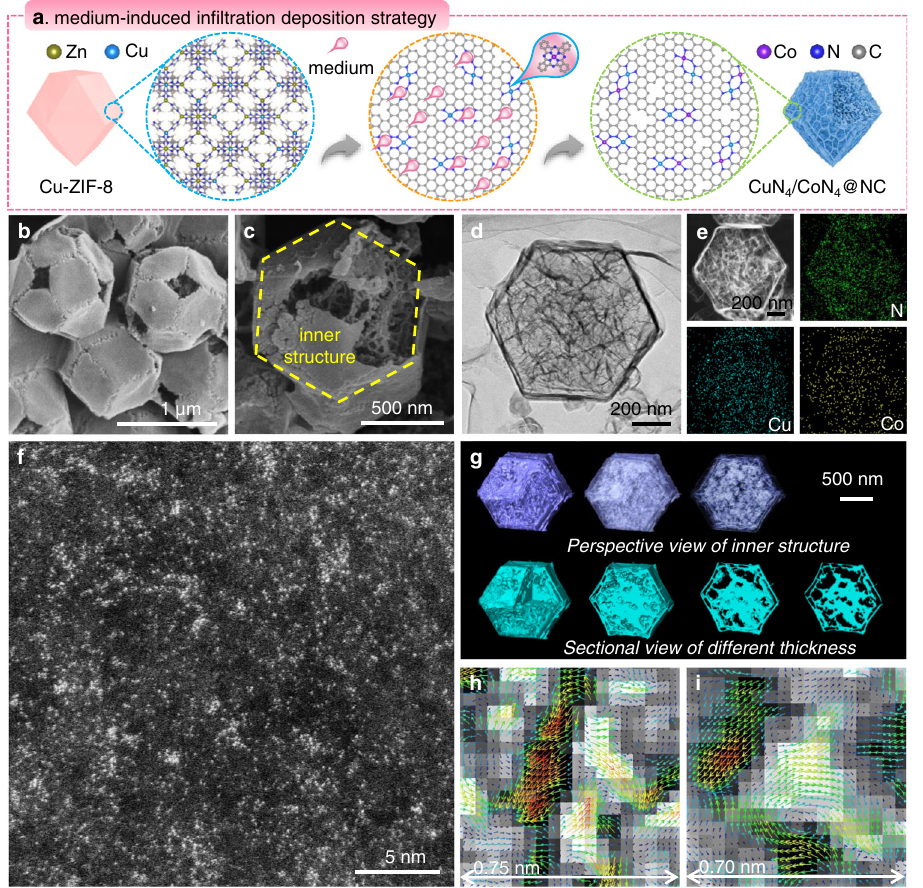
Fig. 1 | Synthesis and structural characterizations of CuN 4 /CoN 4 @NC. a Schematic illustration of the synthesis strategy. b , c SEM, d TEM, e HAADF-STEM and corresponding elemental mapping, and f AC HAADF-STEM image. g